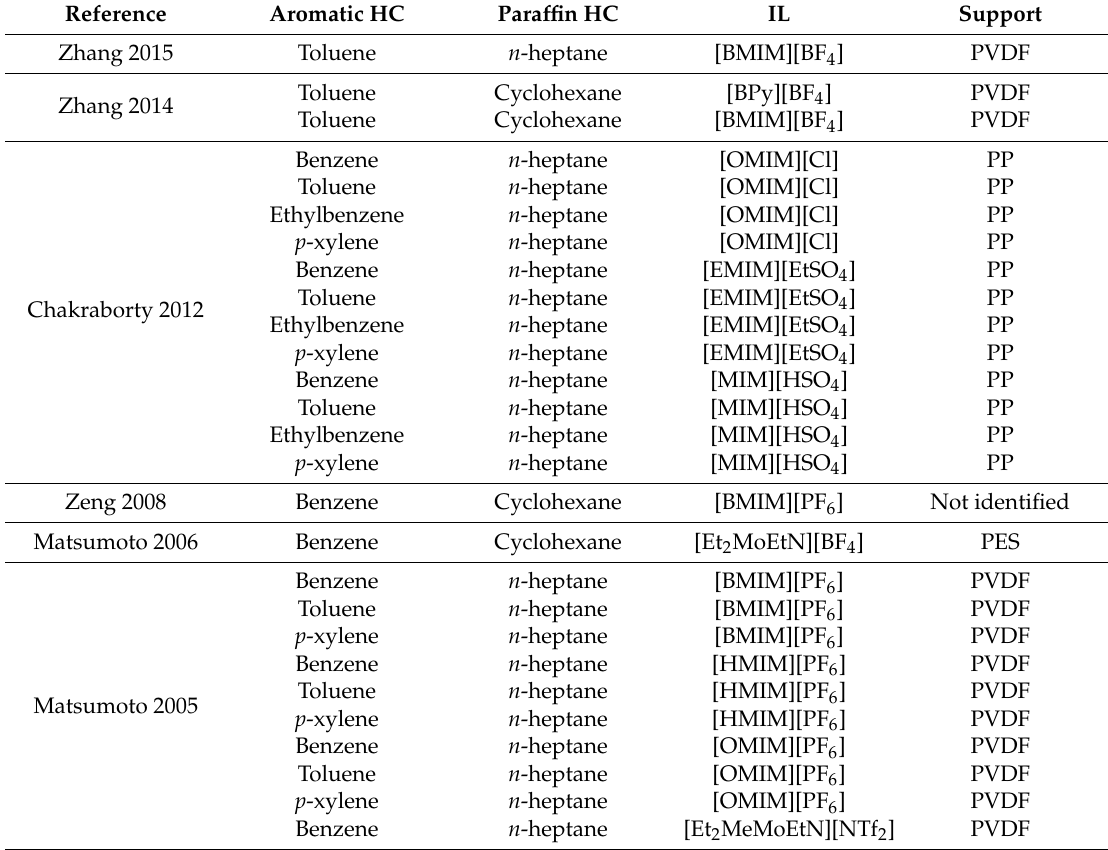
Table 6. Examples of use of SILMs in hydrocarbon